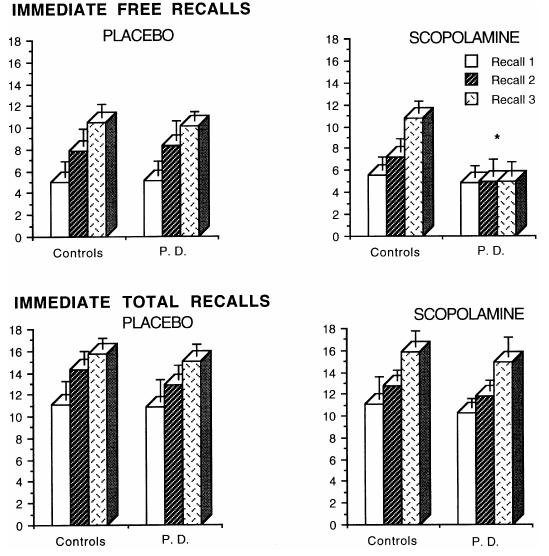
Fig. 1. Grober & Buschke verbal memory test.